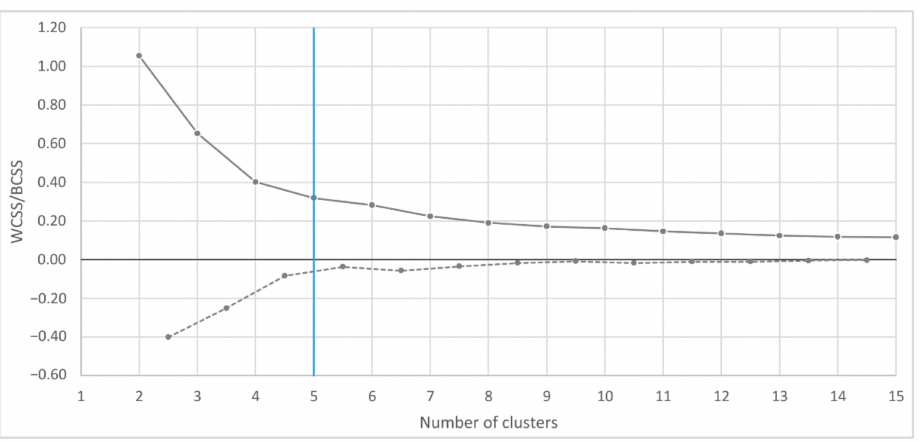
Figure 4. Plot of the WCSS/BCSS ratio (solid line) and gradient m of the WCSS/BCSS curve (dashed line). The blue line marks the change in slope occurring in correspondence to the five clusters. Adding more clusters, the WCSS/BCSS ratio becomes almost constant and does not provide further details to the classification